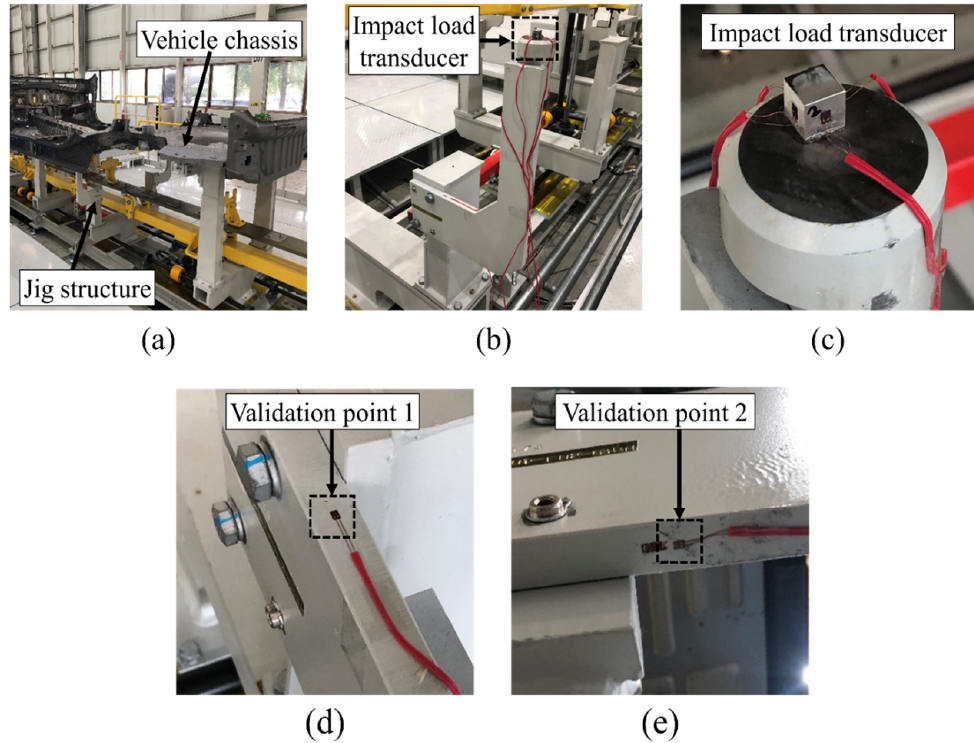
Figure 6. Illustration of impact experiment in Hyundai Motors production line. ( a ) Jig structures and vehicle chassis; ( b ) jig structure installed with impact load transducer and strain gauges; ( c ) impact load transducer mounted on impact point; ( d , e ) strain gauges attached to the stress concentration region for validating FE simulation.